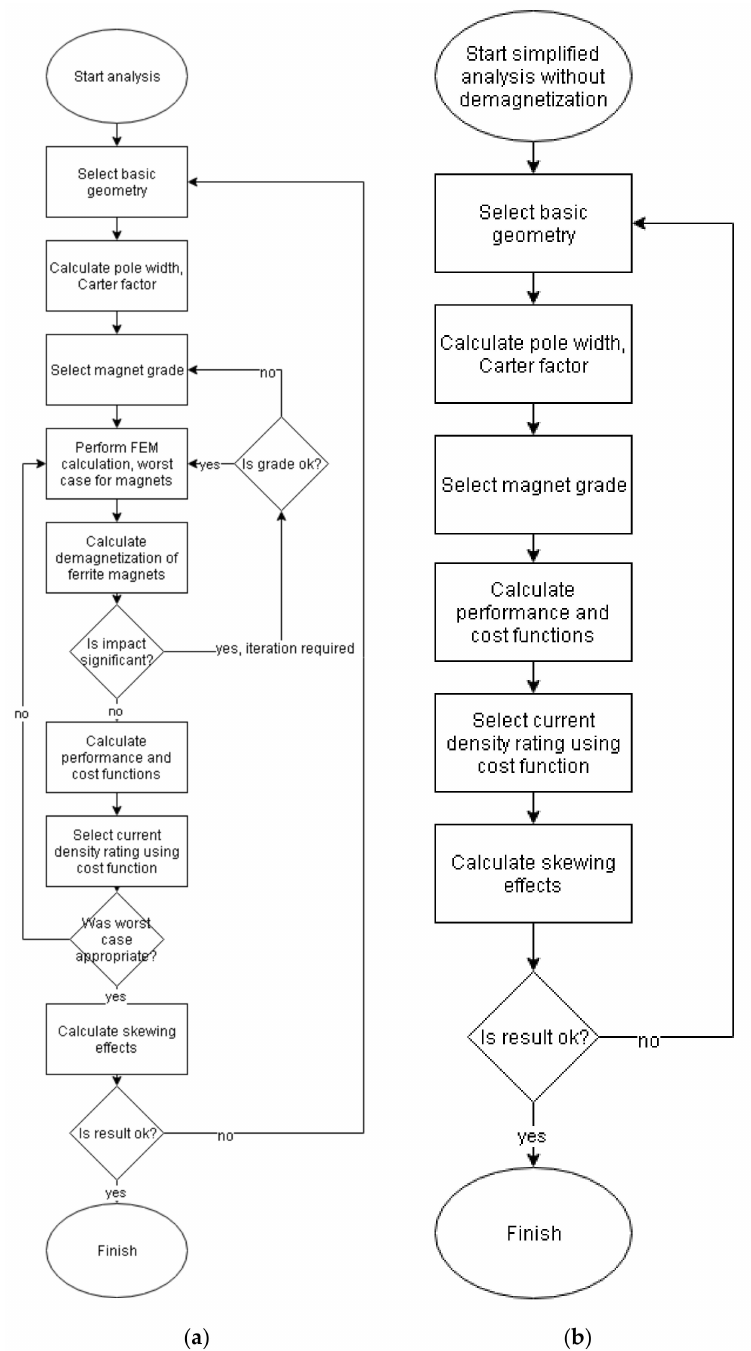
Figure 7. Flow charts for the electromagnetic design process for the ferrite magnet generator, where ( a ) takes demagnetization effects into regard and ( b ) does